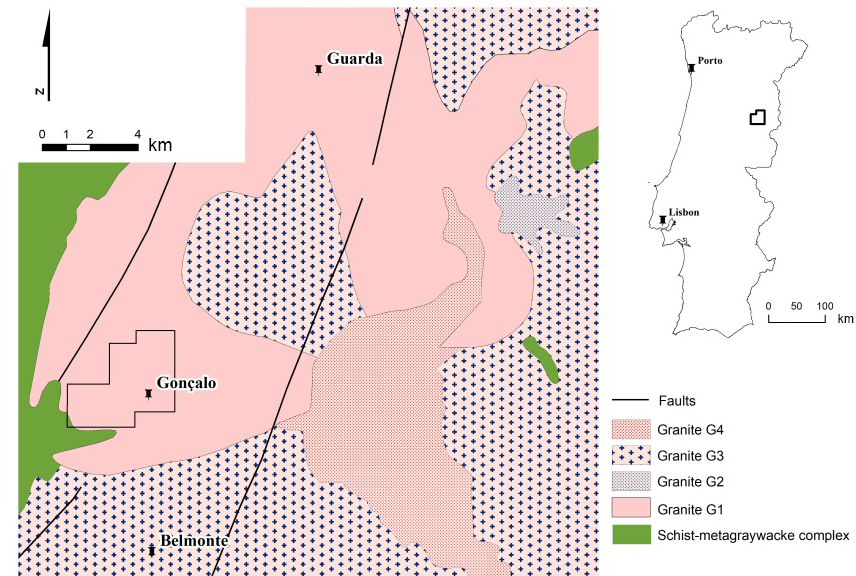
Figure 1. Geographic and geological setting of the lithium Alvarrões-Gonçalo deposit (adapted from Neiva and Ramos, 2010). G1 – biotite granite (Guarda granite); G2, G3 and G4 – biotite-muscovite